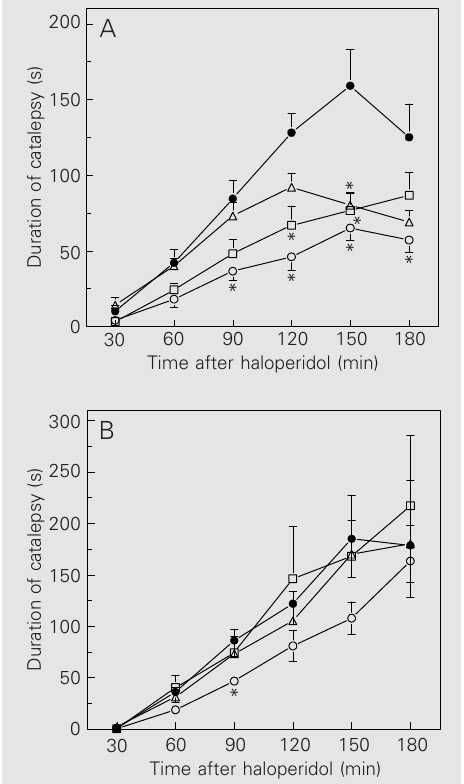
Figure 1. Effects of isosorbide dinitrate (ISD) on neuroleptic-in- duced catalepsy in male (A) and female (B) mice. ISD, or appro- priate vehicle as control, was in- jected ip 30 min before haloperi- dol (1 mg/kg, ip ). Data are re- ported as means ± SEM, N = 10 mice per group. Filled circles, vehicle; triangles, 5 mg/kg ISD; squares, 20 mg/kg ISD; open circles, 50 mg/kg ISD. *P < 0.05 compared to vehicle (Dunnett